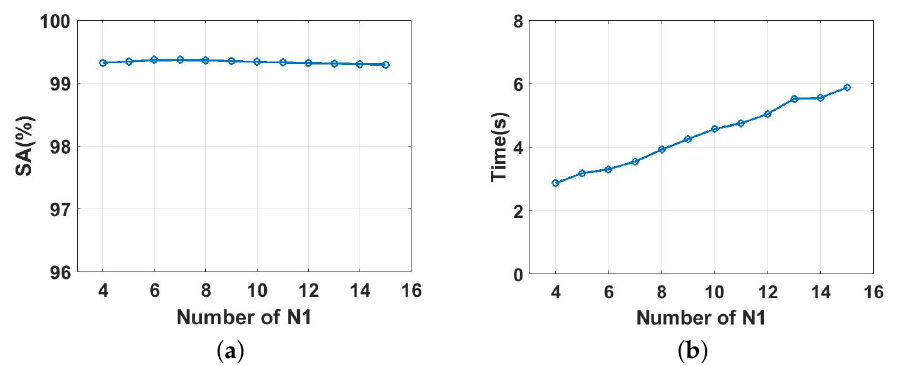
Figure 10. The impact of parameter N 1 on the result: ( a ) yhe impact on accuracy, ( b ) the impact on time